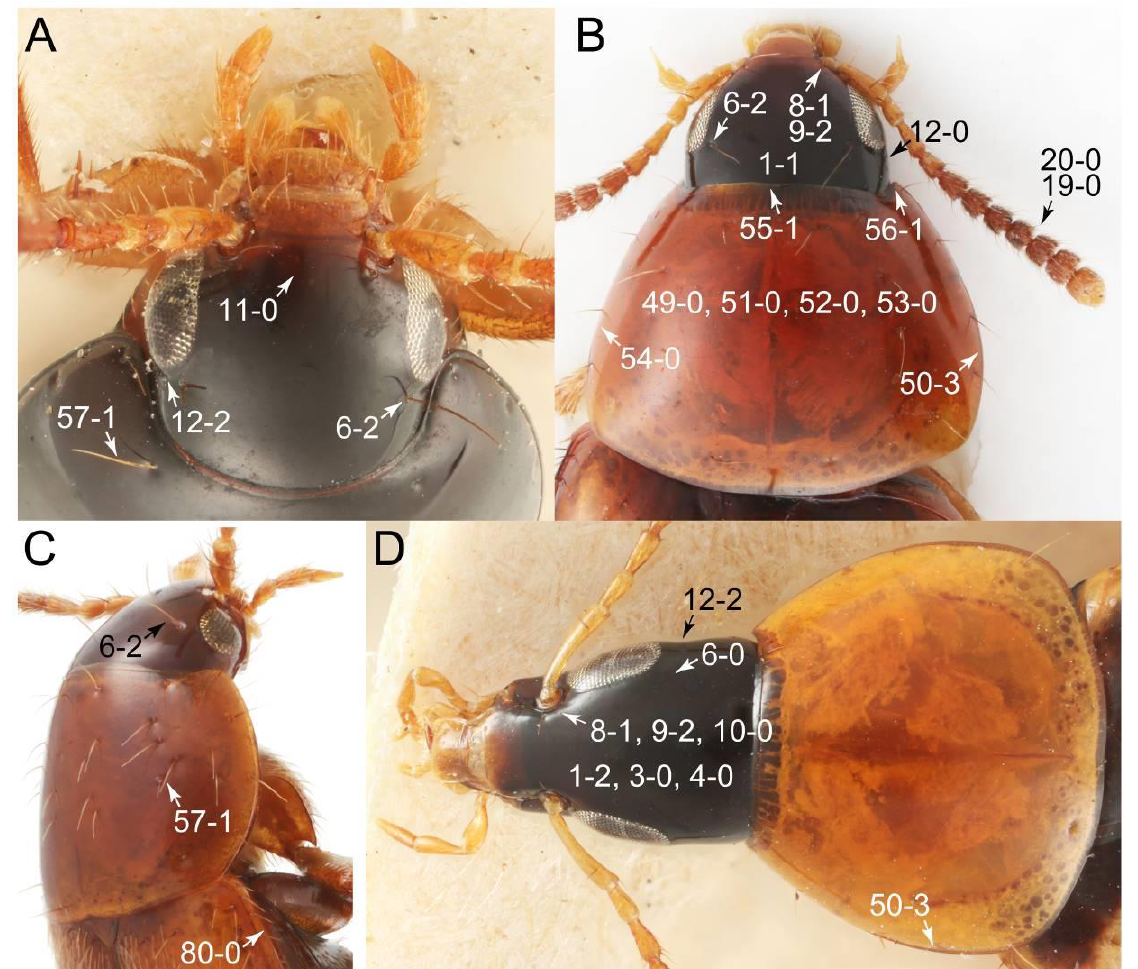
Figure 64. Photographs of body parts of Mycetoporinae, head and pronotum, enlarged. ( A ) Bolitobius castaneus , frontal view. ( B ) Mycetoporus punctus , dorsal view. ( C ) Bolitopunctus sp., dorsolateral view. ( D ) Bobitobus lunulatus , dorsal view. Characters and character states (format X-X) are indicated on each